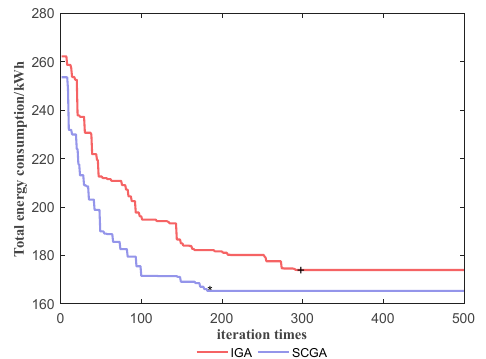
Figure 10. Convergence curve comparison of SCGA and IGA.